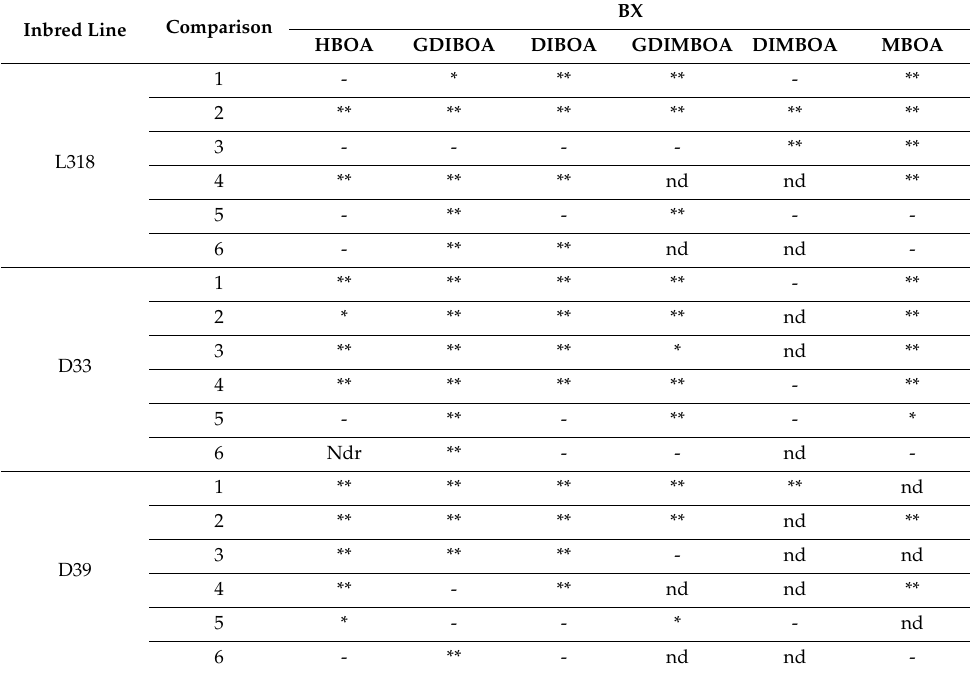
Table 3. Significance of differences in benzoxazinoid (BX) concentration between untreated and cold- treated plants of the rye inbred lines L318, D33, and D39 assessed using the Mann–Whitney U test. Inbred Line Comparison